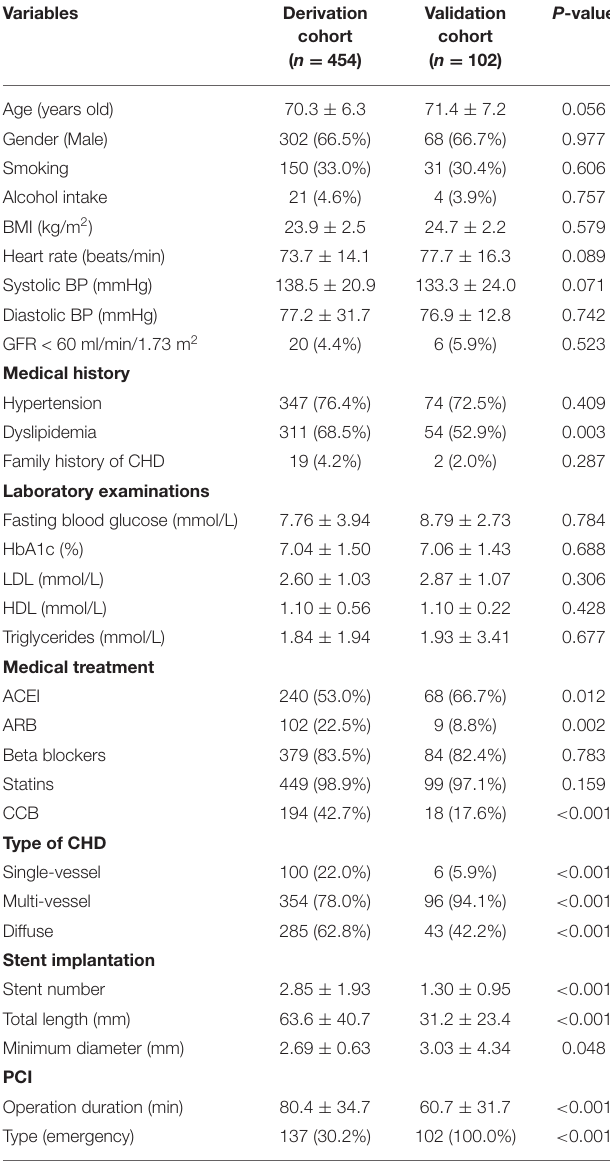
TABLE 4 | Baseline clinical characteristics of derivation cohort and validation